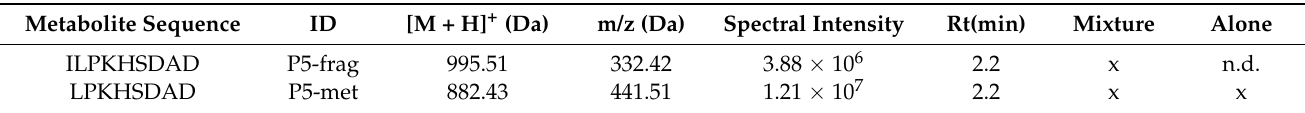
Table 1. Metabolites of P5 identified in the AP compartment of the Caco-2 cell model system at the end of incubation (120 min).